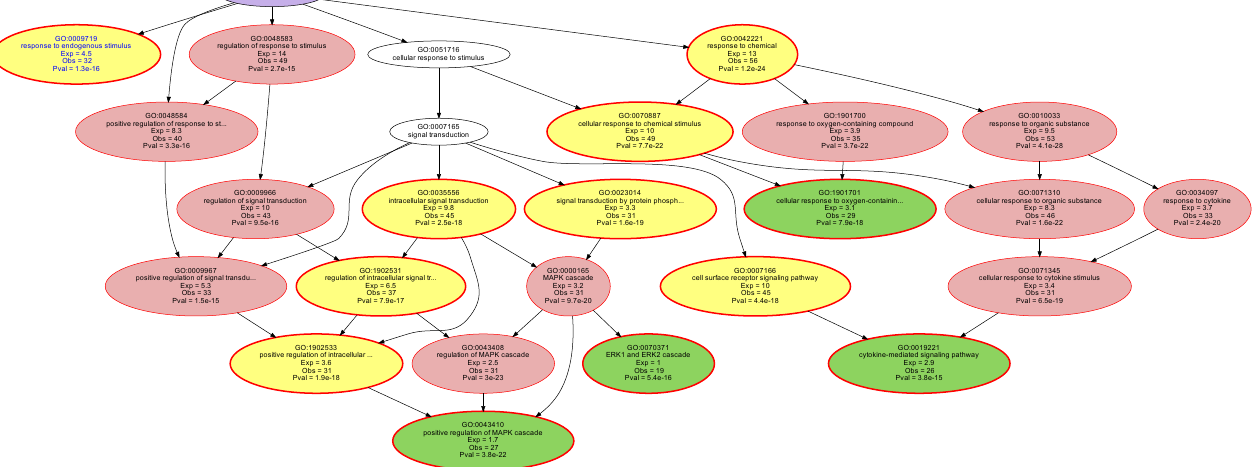
Figure5. . Figure 5. Detail of the directed acyclic graph (DAG [97]) shown in Figure 4, displaying the polyhierarchical structure of the Gene Ontology database (“point of view”) below the GO term “response to stimulus” (GO:0050896). This was one of